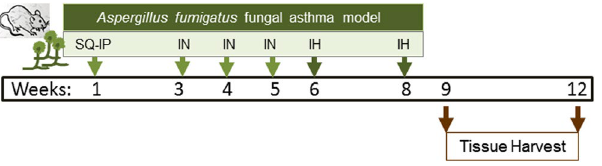
Figure 1. Schematic representation of the timeline in the severe asthma with fungal sensitization model (SAFS). Age and gender-matched mice are administered antigen from Aspergillus fumigatus extract via subcutaneous (SQ) and intraperitoneal (IP) injections. Following a 2 week rest period, antigen is administered via intranasal (IN) route once a week for three weeks. Sensitized mice are then exposed to conidia liberated from live fungal cultures for 10 minutes at a time two weeks apart via inhalation (IH). Samples were harvested at days 7 and 35 after the second fungal